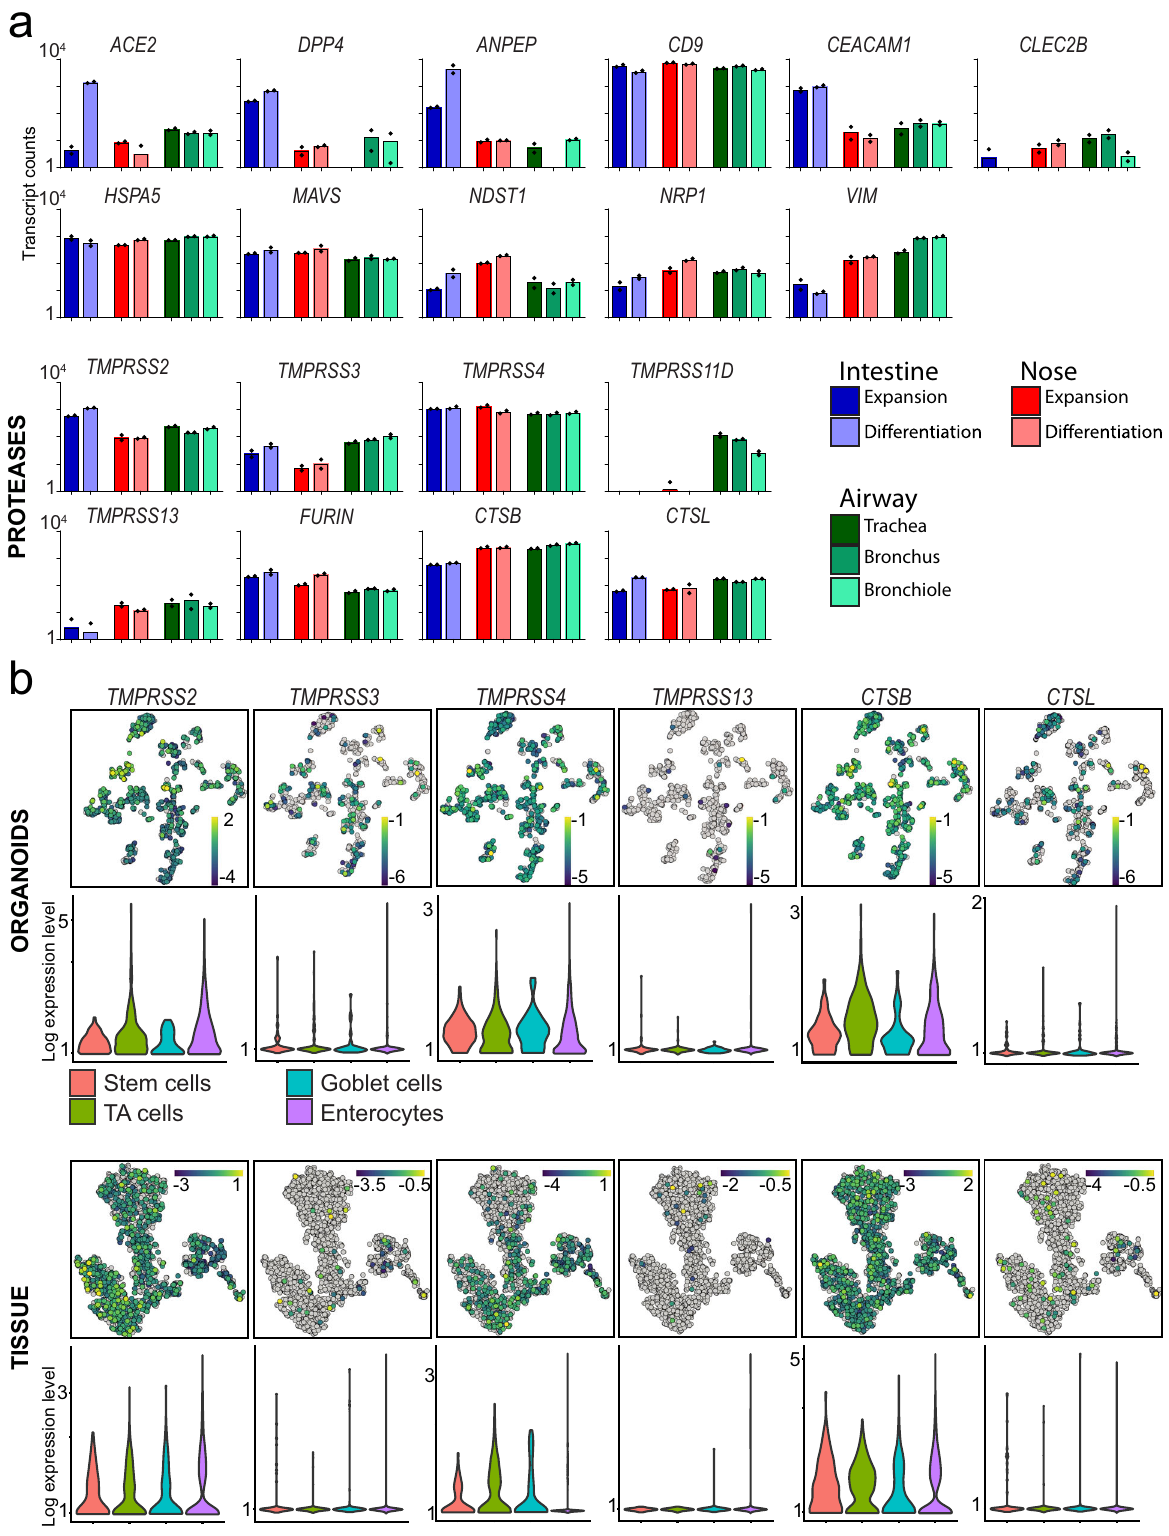
Fig. 1 Expression levels of host genes potentially involved in SARS-CoV-2 biology in lung and intestinal organoids and tissue. a Graphs depicting the transcript counts (logarithmic scale) determined by RNA sequencing of host factors and proteases in organoids derived from different parts of the airway and intestine. Airway organoids (trachea, bronchus and bronchiole) were differentiated as 2D ALI-cultures. n = 2 technically independent samples. b t-SNE maps and violin plots displaying expression of host factors in the human intestinal organoid cell and human intestinal tissue atlases (in vivo atlas derived from 32 . Bars in t-SNE maps display color-coded normalized unique transcript expression (logarithmic